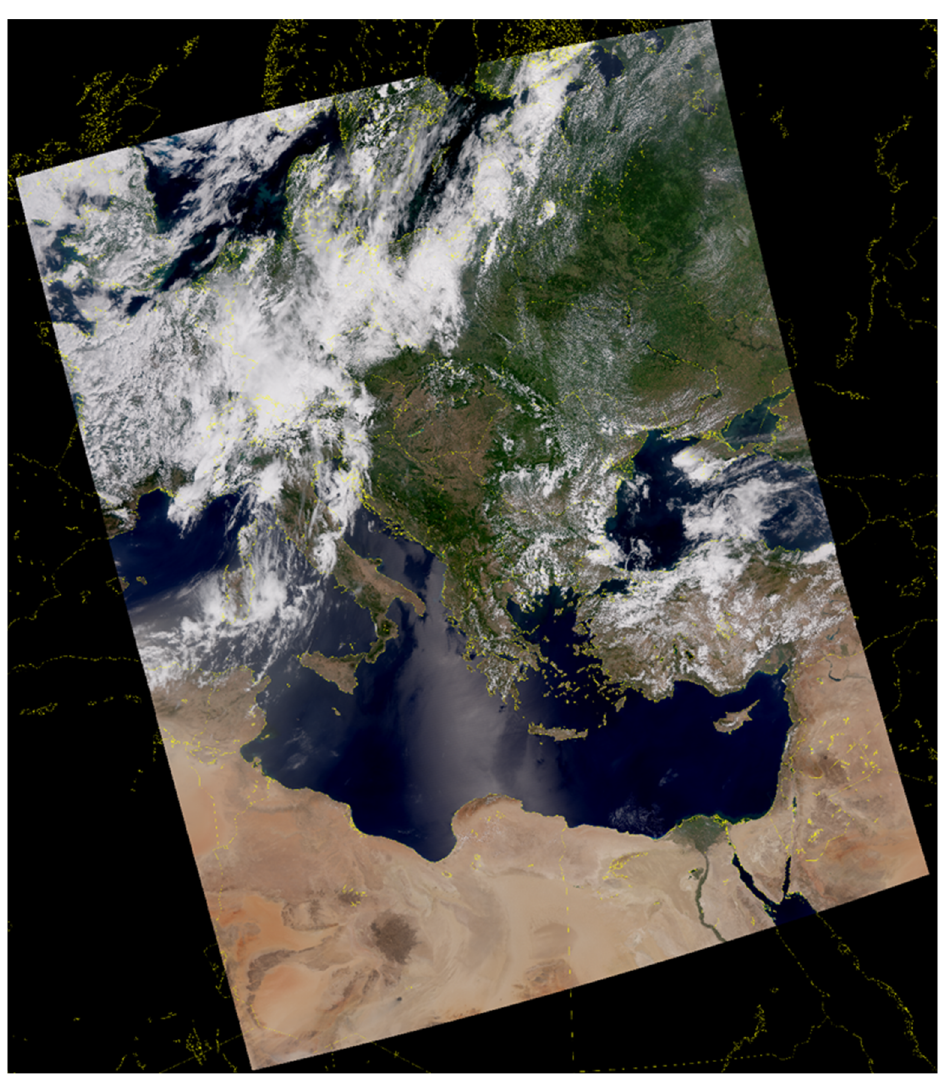
Figure 7. VIIRS EDR true-color operational image from 8 July 2021, created from EDR bands only available after the switch to having all VIIRS bands available as EDRs. The type of image was previously only possible using remapped VIIRS SDRs.